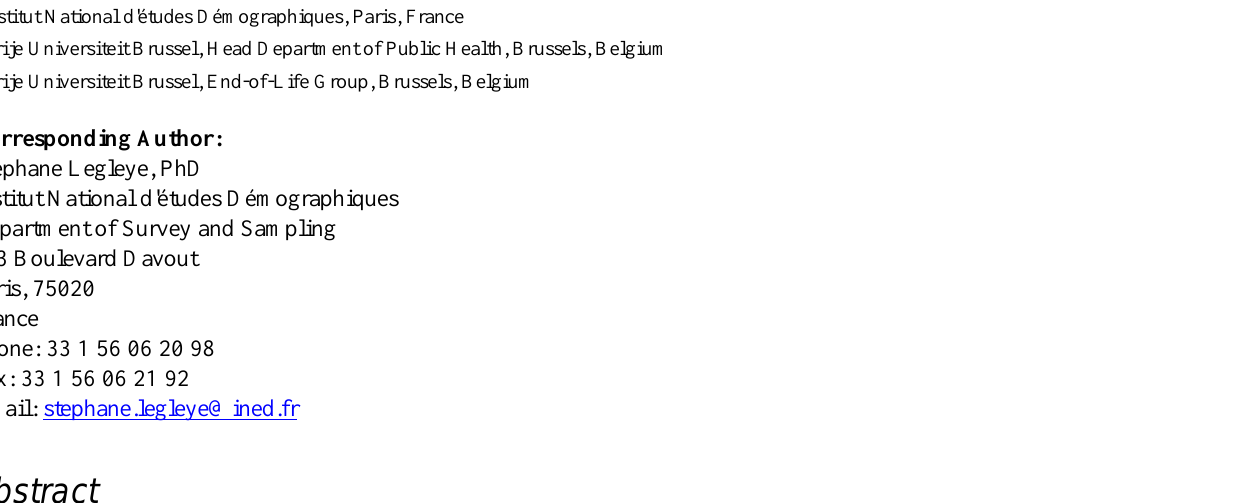
end-of-life decisions; France; methodology; mixed-mode